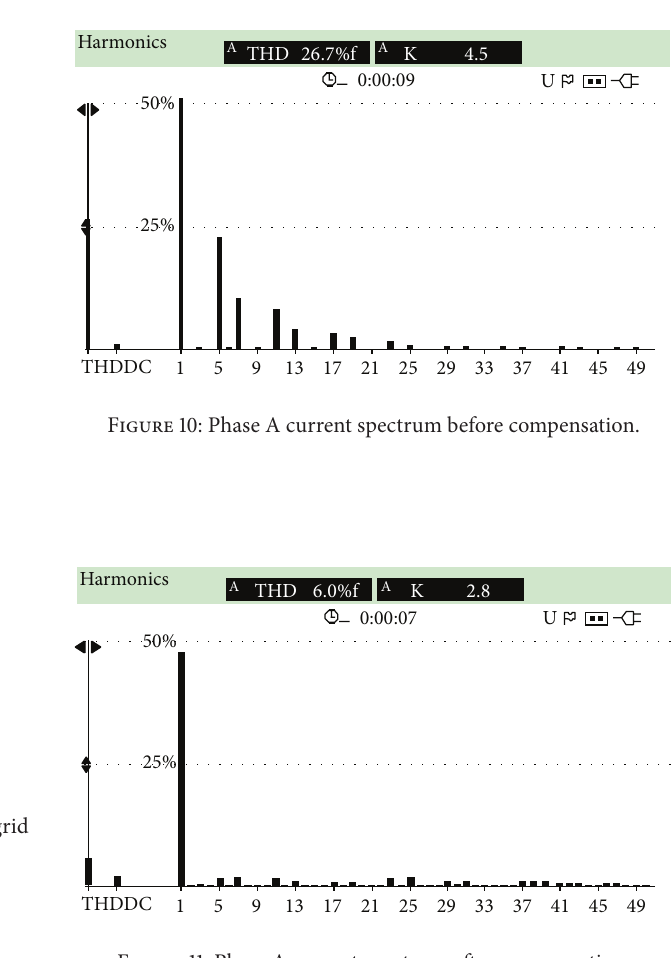
Figure 11: Phase A current spectrum after